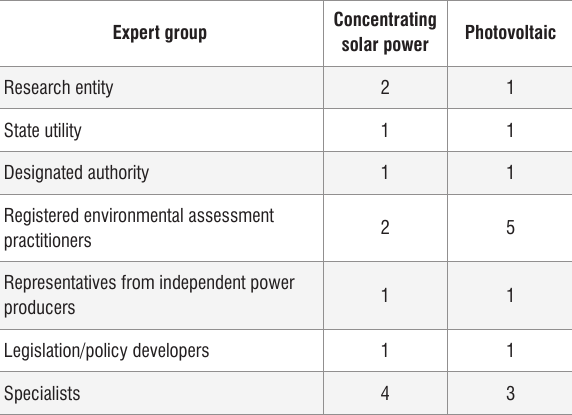
A summary of the representation of the interviewees and the number of responses for the two different solar power